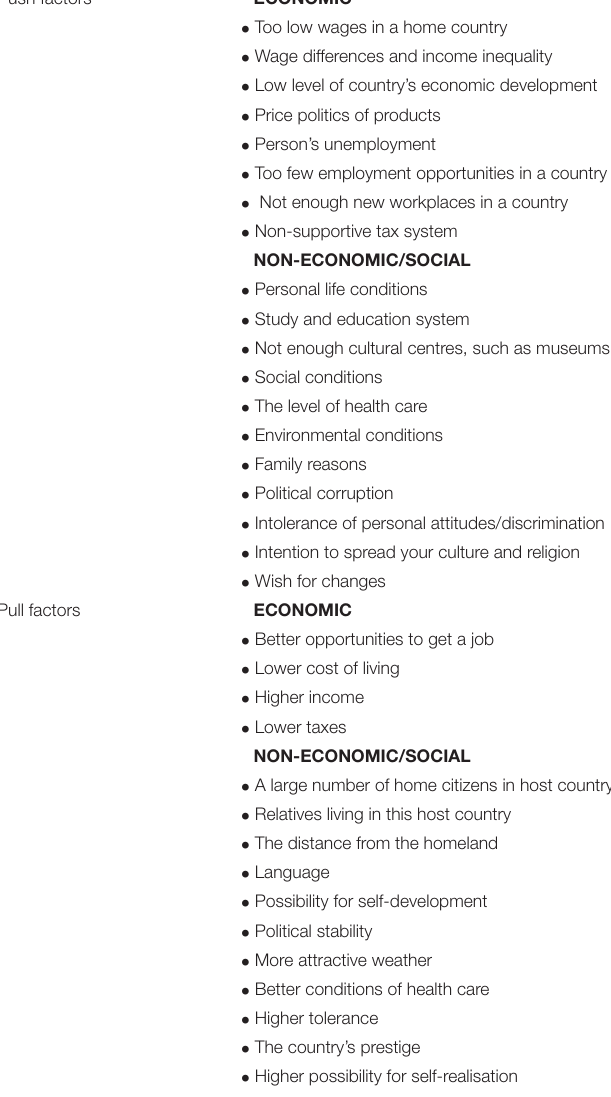
TABLE 1 | Highlighted push-pull